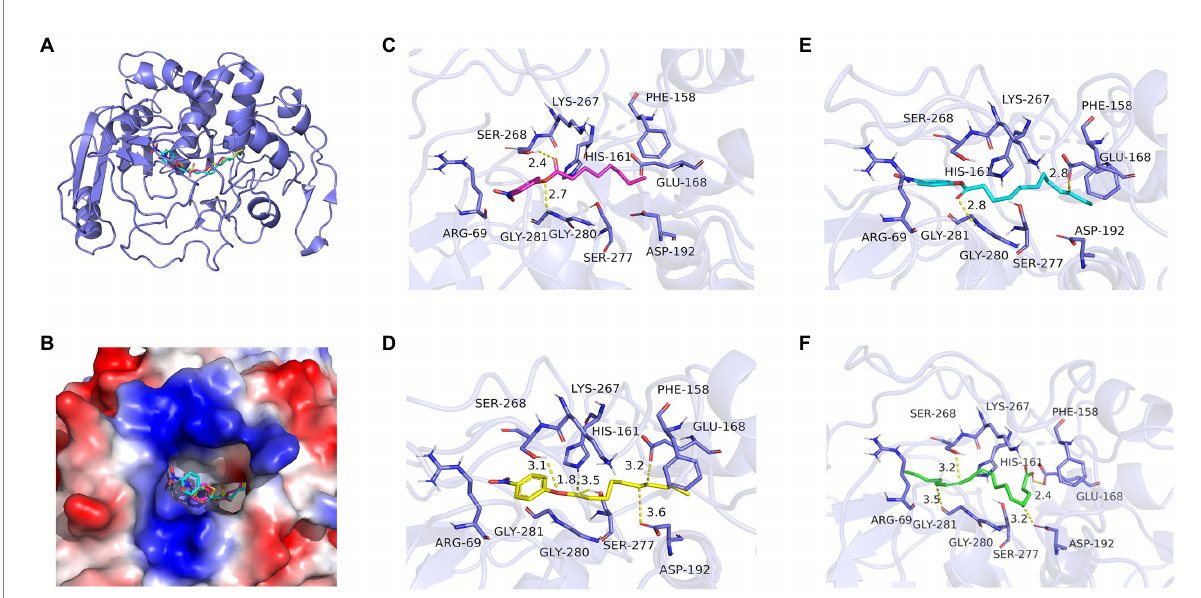
FIGURE 9 Molecular docking analysis of Lip54q and several substrates. (A) The 3D structure of the complex formed by Lip54q and C10 substrate. (B) Surface electrostatics of complexes formed by Lip54q and C10 substrates. Red is positive, blue is negative. (B) The simulation of electrostatic distributions on the surface of the complex formed by Lip54q and C10 substrate. Blue represents positive charge, and red represents negative charge. (C) The intermolecular force analysis of Lip54q bound to C8 substrate. (D) The intermolecular force analysis of Lip54q bound to C10 substrate. (E) The intermolecular force analysis of Lip54q bound to C12 substrate. (F) The intermolecular force analysis of Lip54q bound to linoleic acid substrate. The yellow dashed lines represent hydrogen bonding forces.